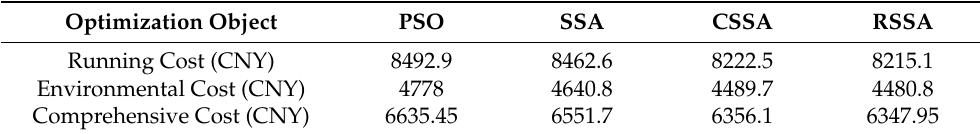
Table 11. Comparison of optimization results of different algorithms for a typical day in winter. Optimization Object